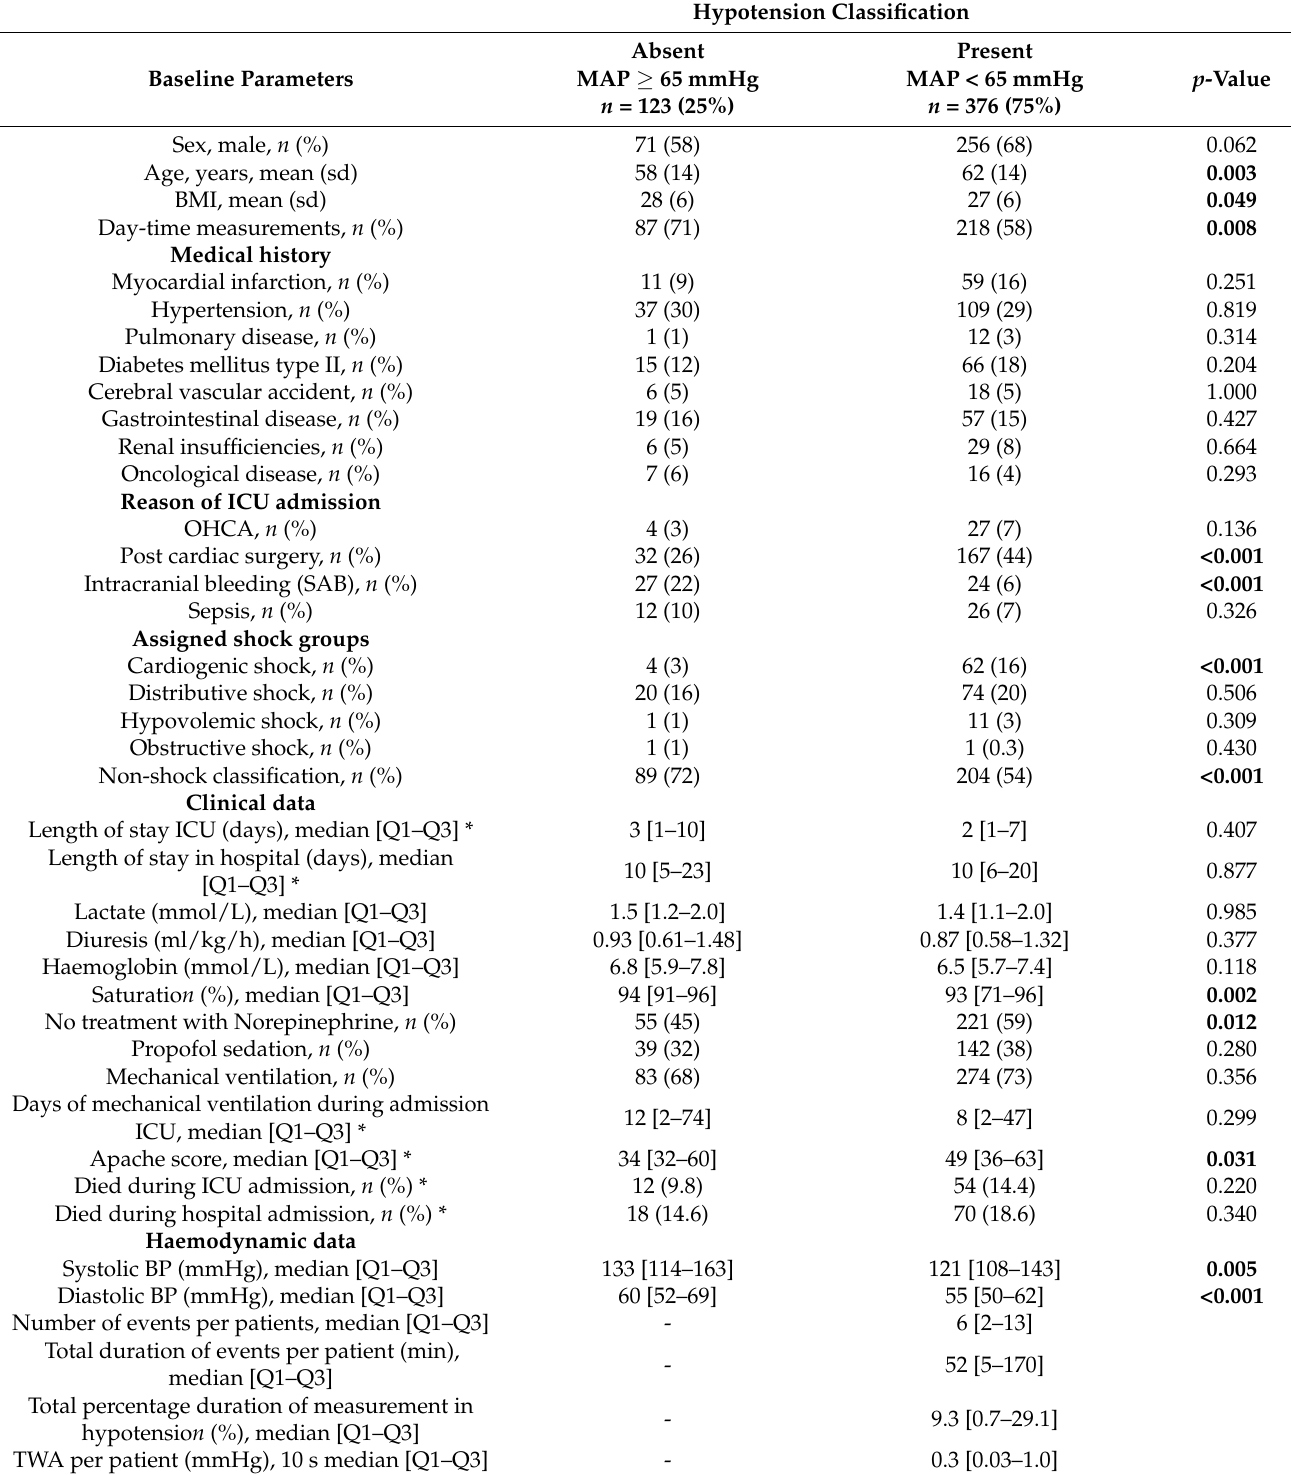
Table 2. Hypotension (mean arterial pressure < 65